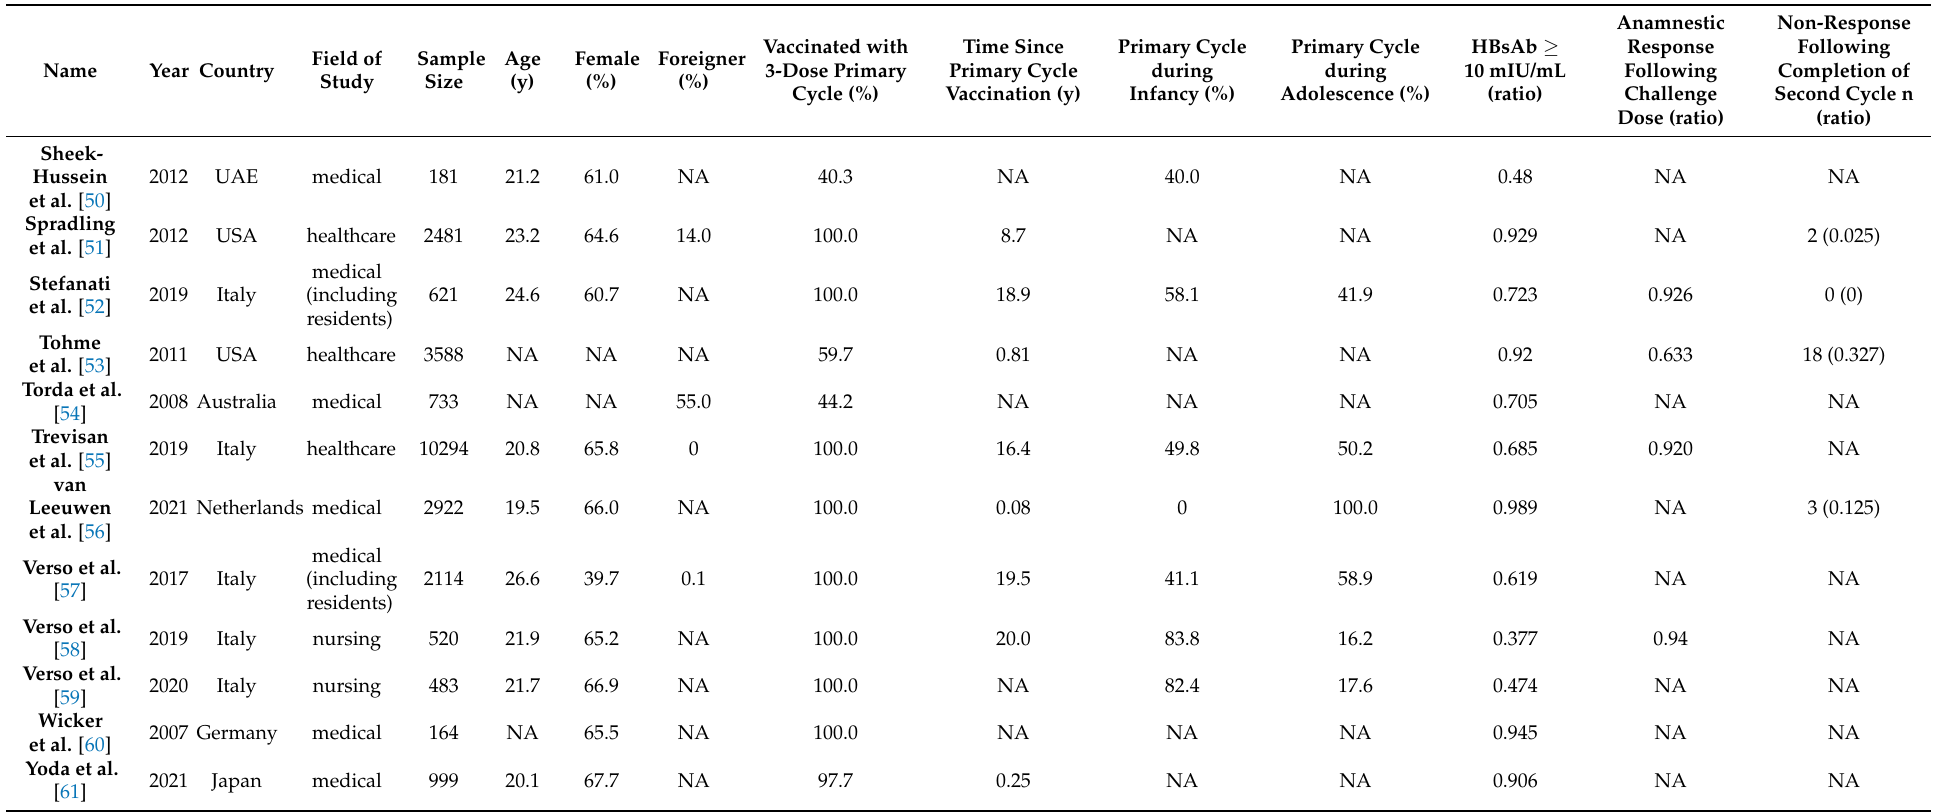
Abbreviation: NA, not